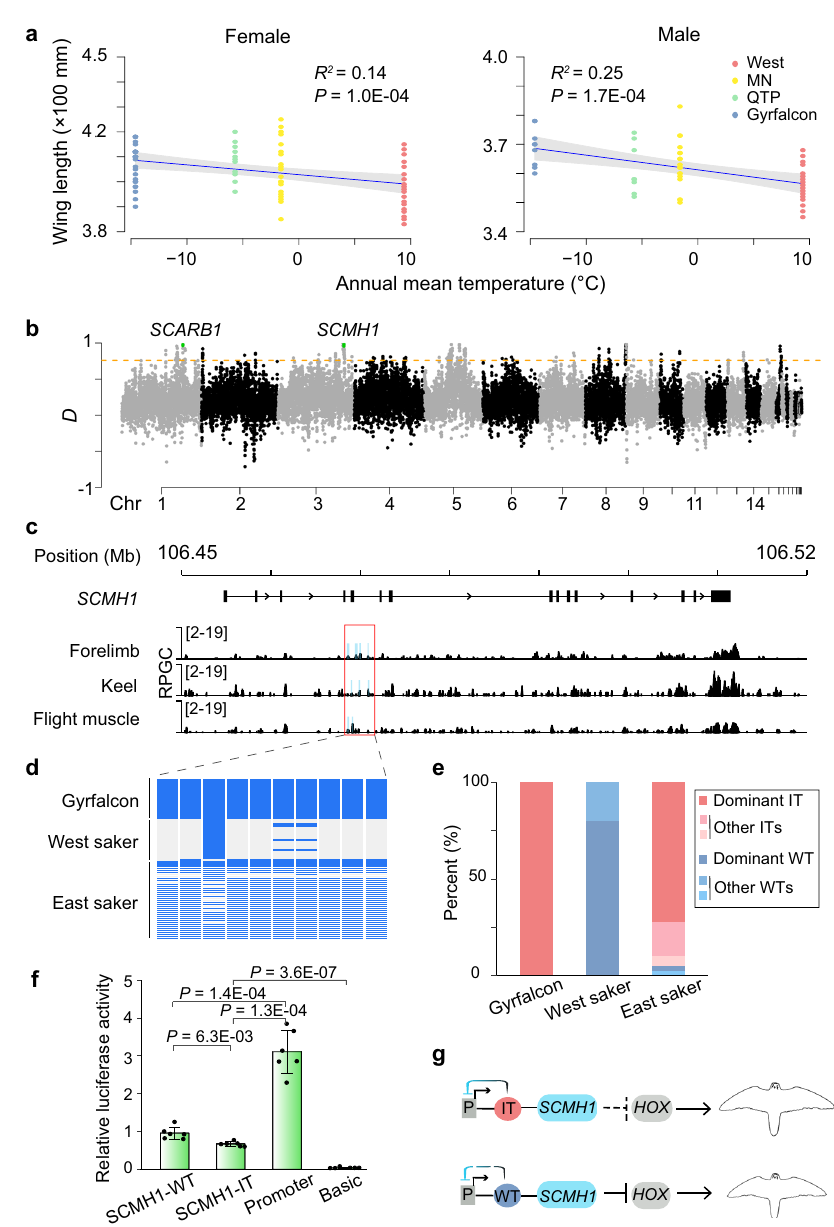
Fig. 2 | Larger body size in East sakers due to hybridization with Arctic gyr- falcons.a Correlationbetweenwinglengthandannualmeantemperatureforboth female (left; 27 gyrfalcons, 50 sakers including 19 from West, 20 from MN and 11 from QTP) and male falcons (right; nine gyrfalcons, 43 sakers including 17 from West, 18 from MN and eight from QTP) using a linear regression model. The mean (blueline)and95%CI(grayband)areshown.Signi fi cancelevelwascalculatedusing F test. b Distribution of D values along chromosomes. The orange line is the thresholdoftop1%value( D =0.73). c ATAC-seqtracks(normalizedusingreadsper genome coverage (RPGC)) around the SCMH1 gene. The sky-blue blocks show the identi fi ed peaks in each sample. The red box shows the cis -regulatory element (CRE) used for the luciferase reporter assay. The window size is 200